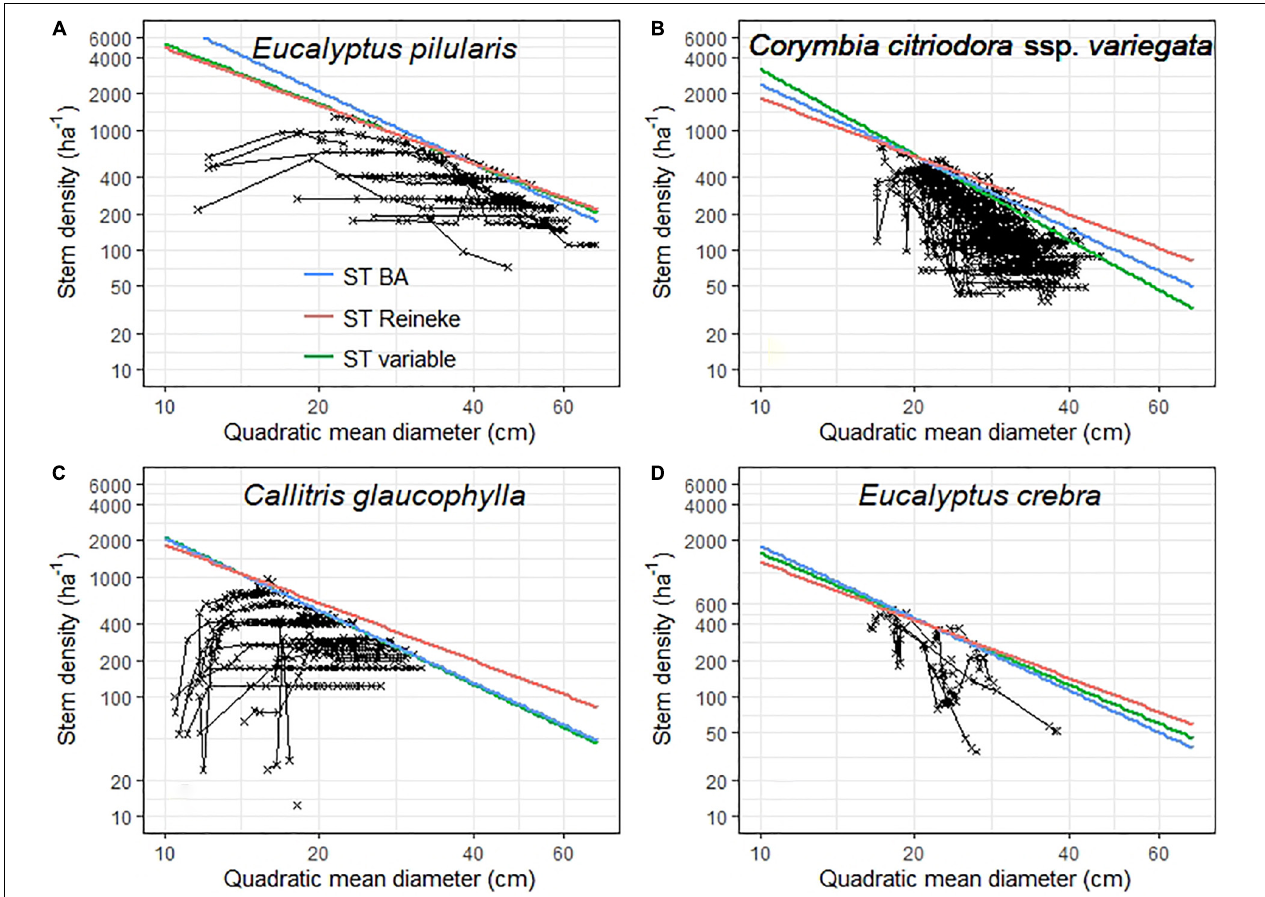
FIGURE 3 | Self-thinning lines for the four main tree species ( A for Eucalyptus pilularis ; B for Corymbia citriodora ssp. variegata; C for Callitris glaucophylla ; D for Eucalyptus crebra ) and unmanaged conditions. In each case, stem density is plotted as a function of tree size, where size was determined as the quadratic mean tree diameter (Eq. 3). Repeatedly measured plots are connected with line segments. We show two theoretically based self-thinning lines. (1) blue lines have a fixed slope of –2.000 (i.e., based on basal area), (2) red lines are a generalized model with slope of –1.605 (based on Reineke, 1933). A third line is shown in green and is derived from quantile regression for each study species. Slopes of the species self-thinning lines were: E. pilularis –1.662; C. citriodora –2.366, Callitris glaucophylla –2.042, E. crebra –1.832). In panel C, the blue and green lines